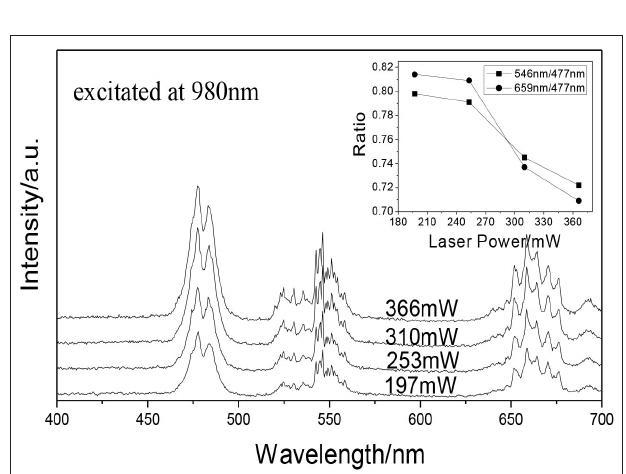
FIGURE 8 | UCPL spectra of the GdAlO 3 : 0.6%Er 3 + , 16%Yb 3 + , 1%Tm 3 + phosphor under excitation at 980nm with different laser powers (inset is the dependence of the 546 nm/476nm and 659 nm/476nm intensity ratio on laser